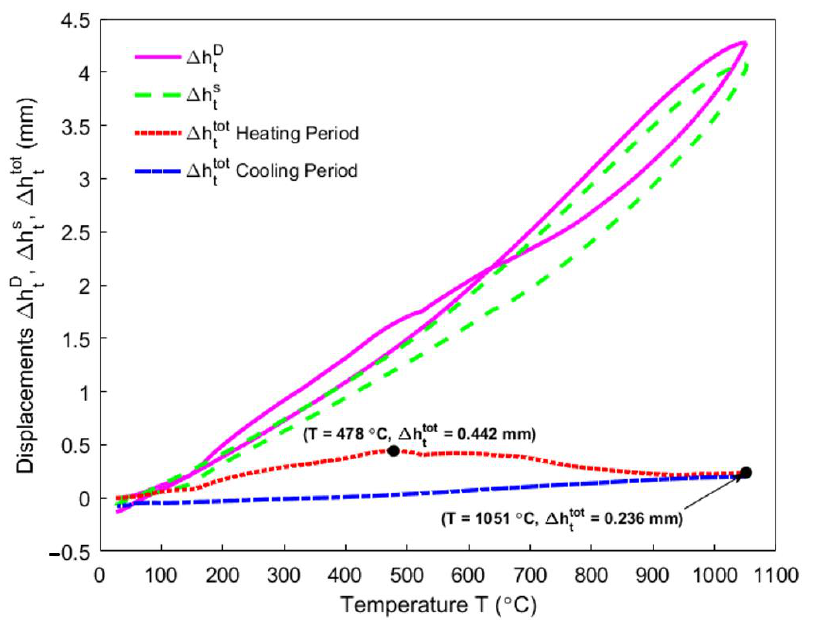
Figure 8. Vertical displacements with respect to the temperature.